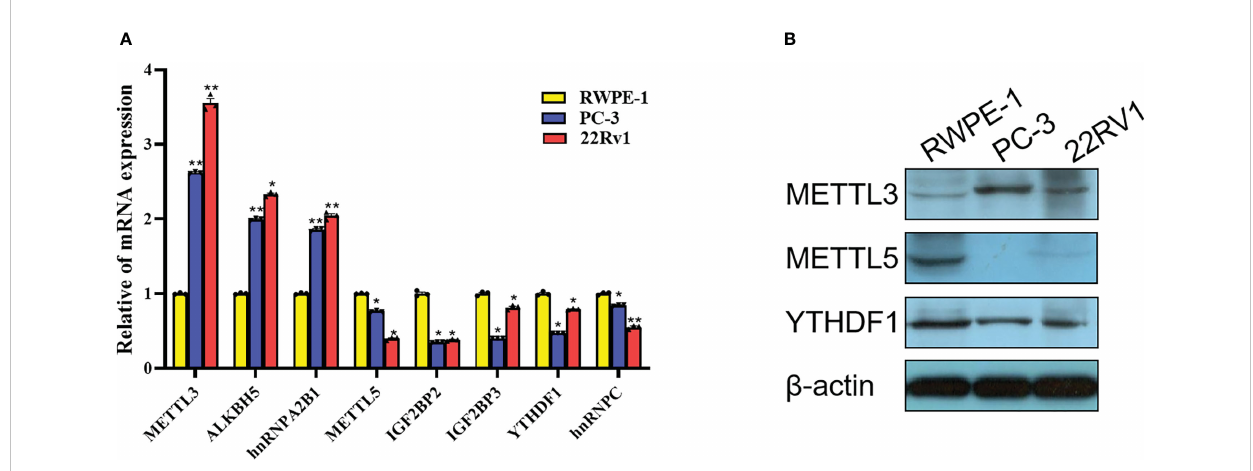
FIGURE 14 Expression validation of m 6 A-related gene in PCa cells. (A) Differences in mRNA expression of 8 m 6 A-related genes in 22Rv1, PC3 and RWPE-1 by RT-qPCR. (B) Differences in protein expression of METTL3, METTL5 and YTHDF1 in 22Rv1, PC3 and RWPE-1 by western blot. *P<0.05,